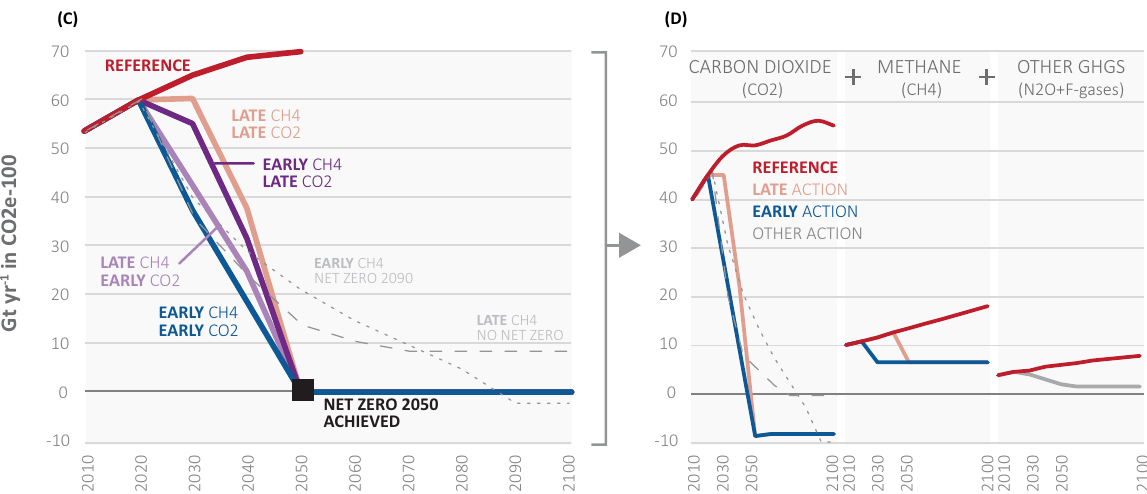
Figure 1. Global emissions pathways and corresponding temperature outcomes discussed in this study. ( A ) Global mean temperature increases relative to the pre-industrial (1850–1900) period resulting from various global emissions pathways shown in ( C , D ). ( B ) The near-term (2030–2040) rate of warming and mid-term (2050) temperature increase corresponding to ( A ). ( C ) Global GHG emissions pathways (Gt CO 2 e-100; calculated using Global Warming Potentials with a 100-year time horizon 1 ) used in this study. ( D ) The breakdown of carbon dioxide, methane, and other GHG emissions (nitrous oxide and fluorinated gases) in ( C ). Colored solid lines and markers indicate pathways that meet the net zero GHG emissions by 2050 target. Gray dashed lines and markers indicate pathways that do not meet the net zero GHG emissions by 2050